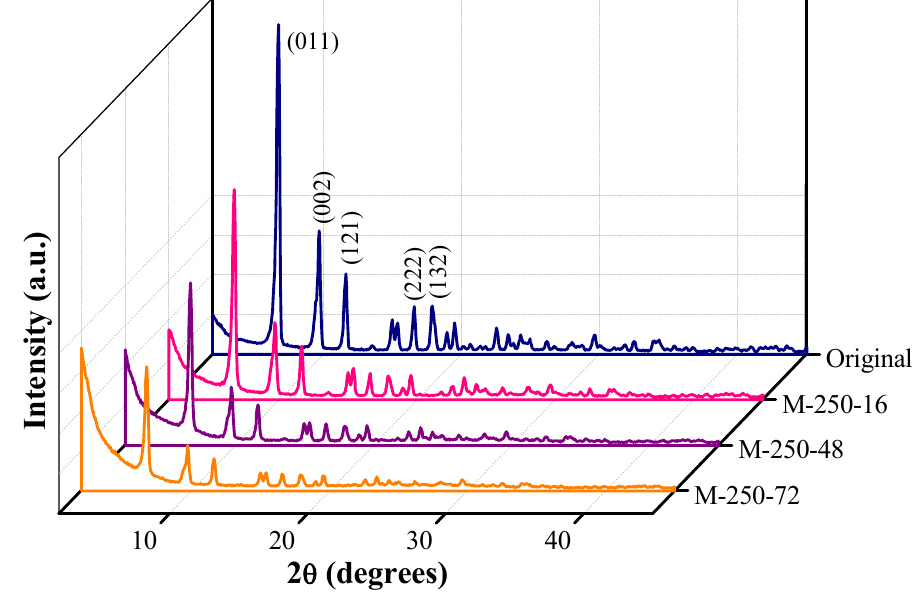
Figure 7. XRD di ff raction patterns of NH 2 -MIL-125(Ti) heated in air at 250 ◦ C for 16, 48 and 72 h. Figure 7. XRD diffraction patterns of NH 2 -MIL-125(Ti) heated in air at 250 °C for 16, 48 and 72 h. The The original NH 2 -MIL-125(Ti) pattern is included as original NH 2 -MIL-125(Ti) pattern is included as reference.